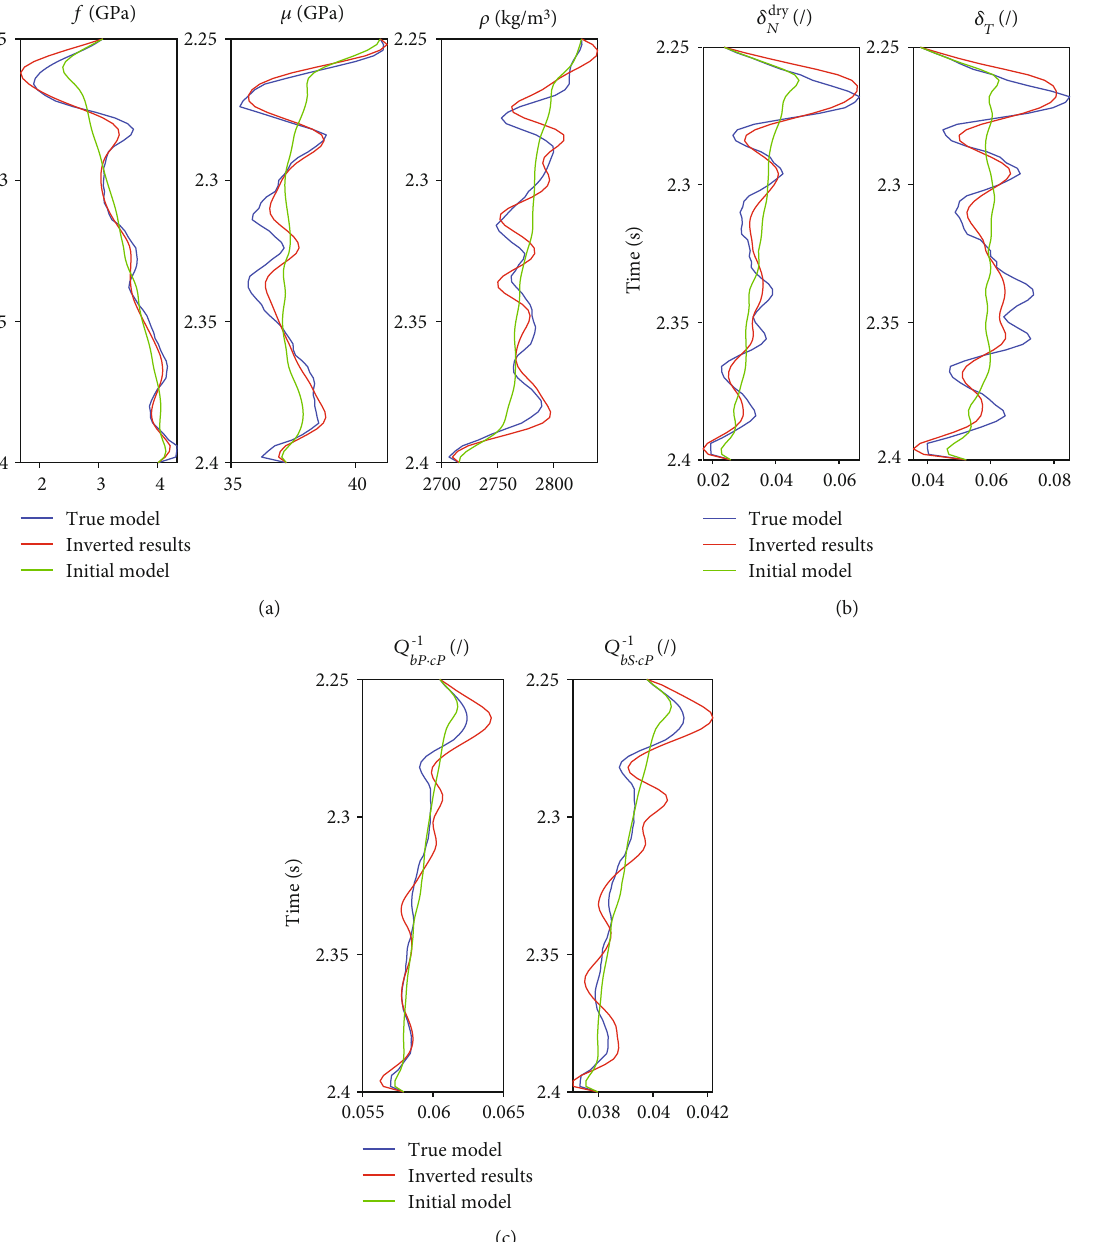
Figure 4: Estimated model parameters using the azimuthal attenuation EI inversion with SNR being 2, where (a) shows the fl uid/porosity term, shear modulus, and density; (b) shows the normal and tangential fracture weaknesses; and (c) shows the attenuation